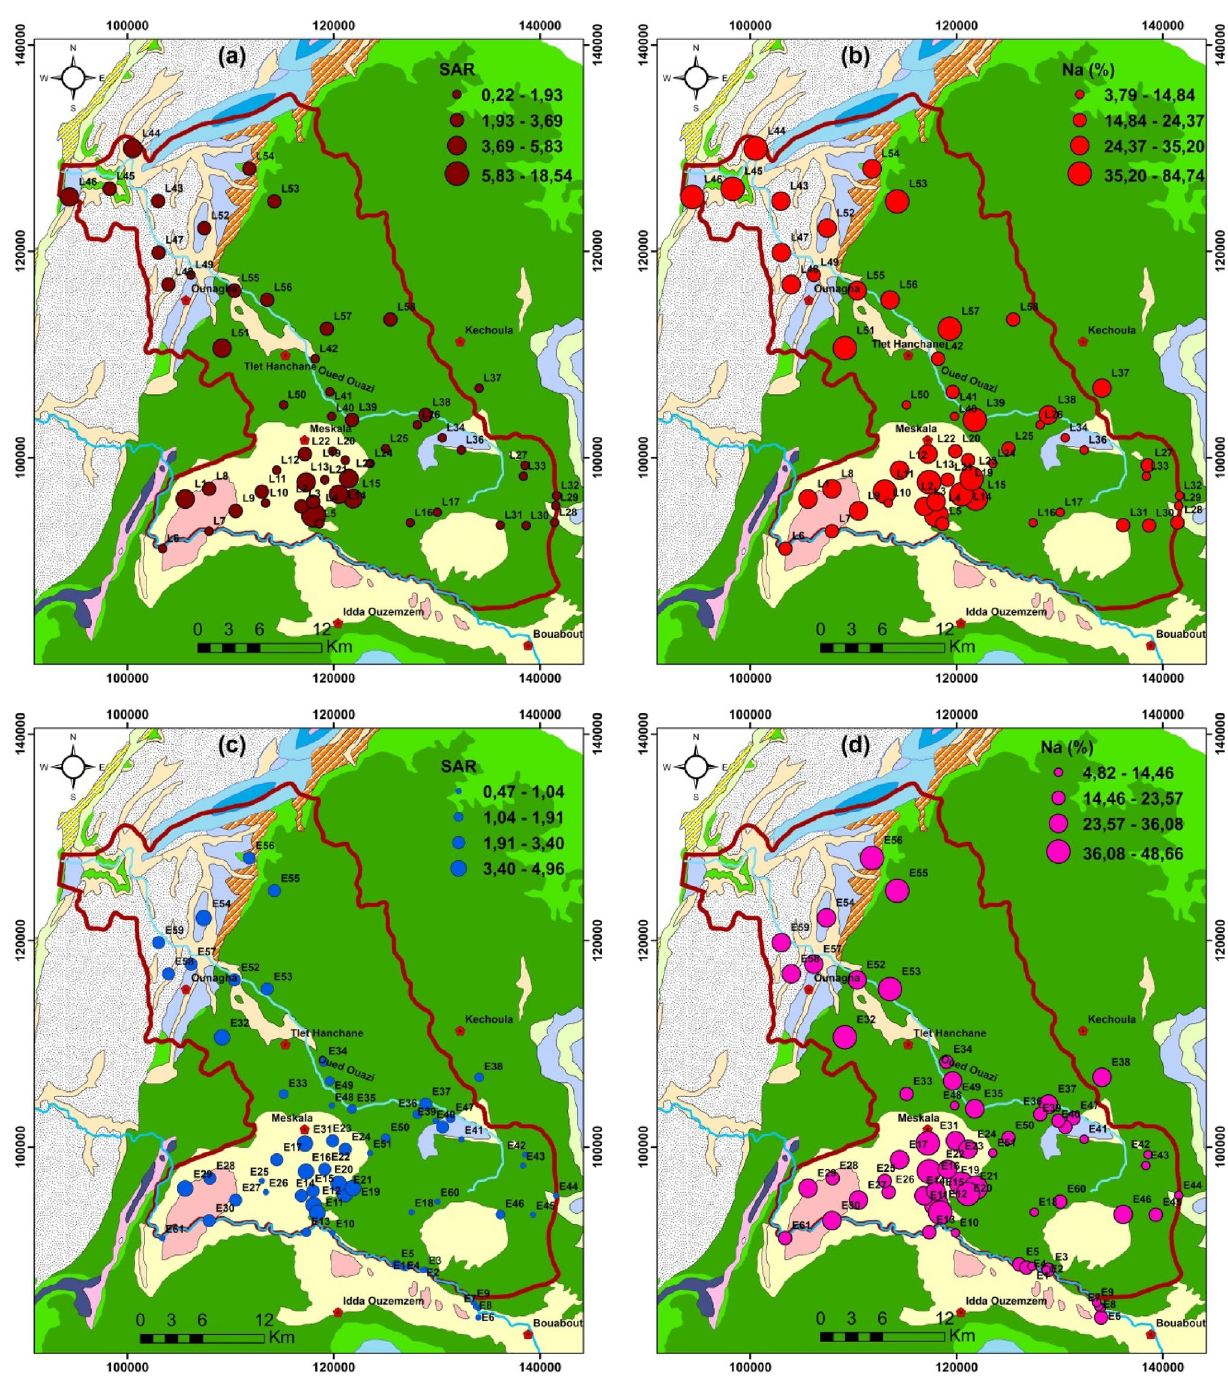
Fig. 5 Spatial distribution map of SAR and Na (%) of the campaign 2019 and 2020,